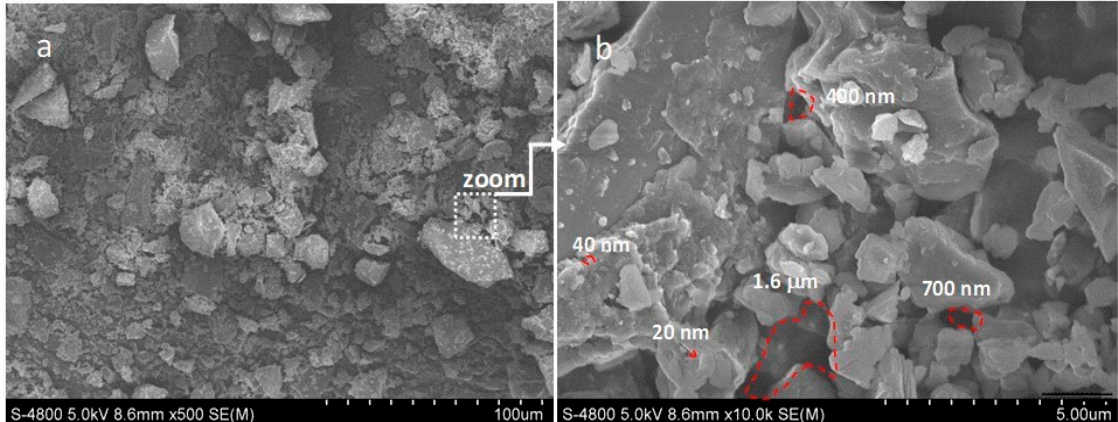
Figure 5. Scanning electron micrographs (SEM) of the EOP biochar: ( a ) at 100 µ m resolution and ( b ) at 5 µ m resolution